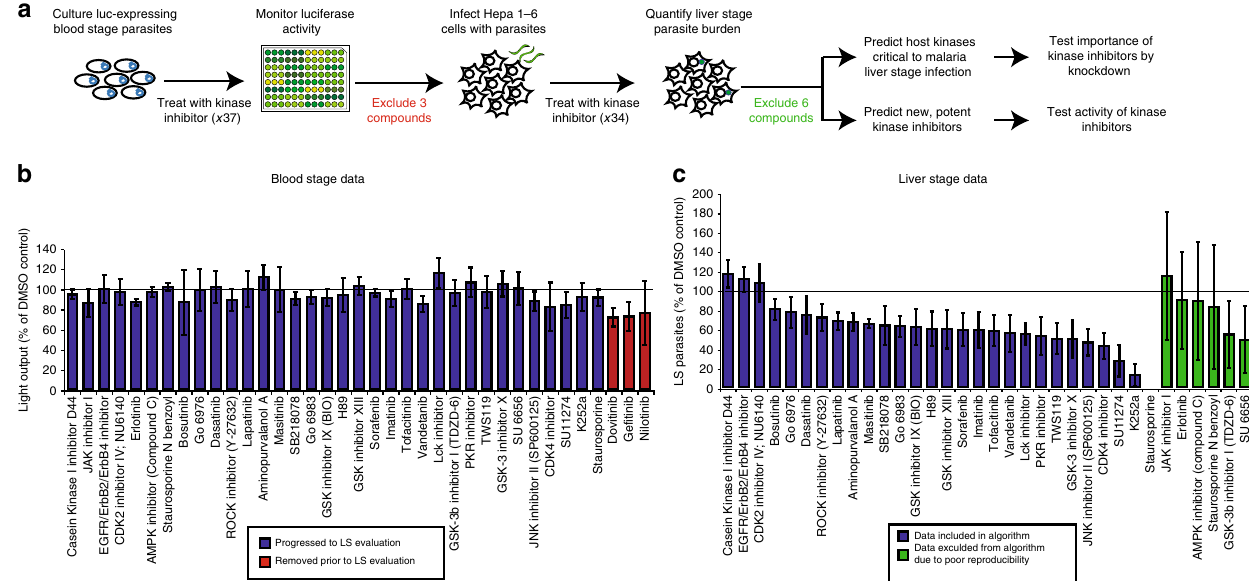
Fig. 1 Plasmodium LS development is differentially impacted by host-targeted kinase inhibitors. a Schematic representing work fl ow to identify host kinases involved in LS infection by kinase pro fi ling and elastic net regression. b P. falciparum GFP-Luciferase expressing blood stage parasites were cultured at 2% parasitemia in 5% hematocrit and evaluated for growth in response to 37 kinase inhibitors at 44 h.p.i. Light output was used as a surrogate measurement for parasite biomass. Values are normalized to the light output of non-treated parasites, which is indicated by a solid line. Kinase inhibitors that exhibited toxicity against blood stage parasites were removed for subsequent study (depicted in red). Data is the average of three independent experiments. c 150,000 Hepa 1 – 6 cells were infected with 50,000 P. yoelii parasites and then treated with kinase inhibitors at 500 nM 1.5 h.p.i. P. yoelii LS development in the presence of kinase inhibitors was evaluated by microscopy at 24 h.p.i. All values are normalized to vehicle-treated control (indicated by a solid line). Kinase inhibitors that exhibited high variability in parasite clearance were excluded from downstream analysis (depicted in green). Data shown is the average of 3 – 4 independent experiments. Error bars represent standard deviation of independent experiments. Individual data points are provided